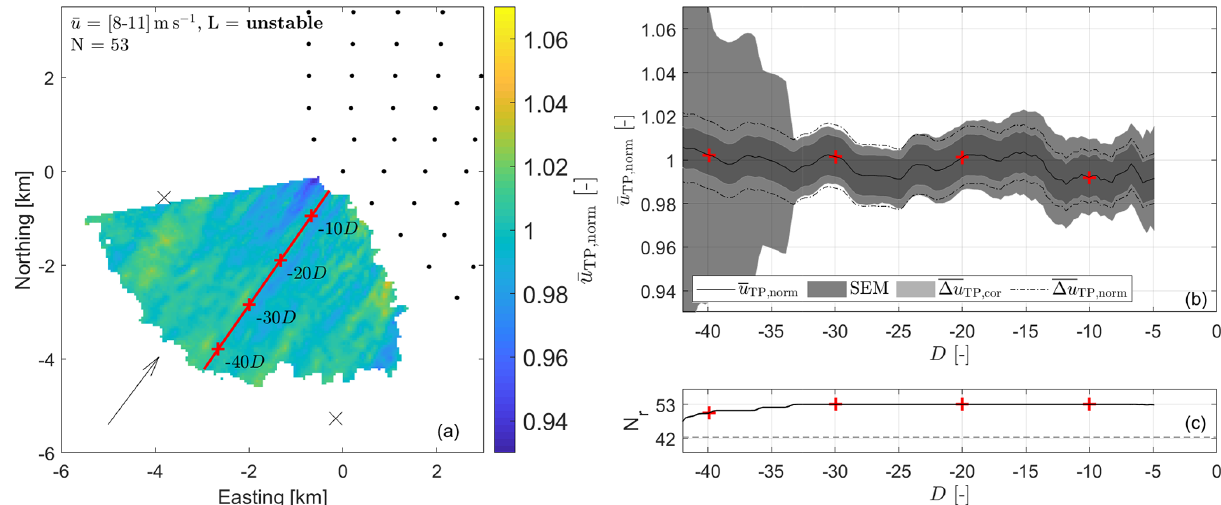
Figure 4. Scenario 1: analysis of lidar scans during unstable atmospheric conditions and in cases with a high thrust coefficient with u = [8– 11]ms − 1 , χ = [210–220] ◦ , N = 53, χ = 217 ◦ , u GT58 = 10.11ms − 1 , P GT58 = 4.77MW, the median Obukhov length L med =− 430m and the standard deviation of the wind direction σ χ = 2.68 ◦ . Panel (a) depicts the normalized wind speed u TP,norm averaged over all valid scans N . The arrow displays the mean wind direction χ . u TP,norm along the wind field cut, indicated as a red line in (a) , is shown in (b) . Here, additionally the three estimated uncertainties (cid:49)u TP,cor , SEM and (cid:49)u TP,norm are visualized as grey-shaded areas and a black dotted line, respectively. Be aware that the SEM here overlays (cid:49)u TP,cor . The distance to the lidar on the x axis is given in terms of rotor diameter D . Panel (c) displays the number of valid scans at each grid point N r . The grey horizontal dashed line marks 0 . 8 N . Points highlighted by a red + in (b) and (c) correspond to the locations marked in the lidar cut in (a) and (b)